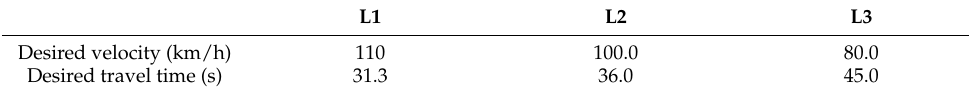
Table 3. Desired velocity and travel time for each vehicle travel through DIA.